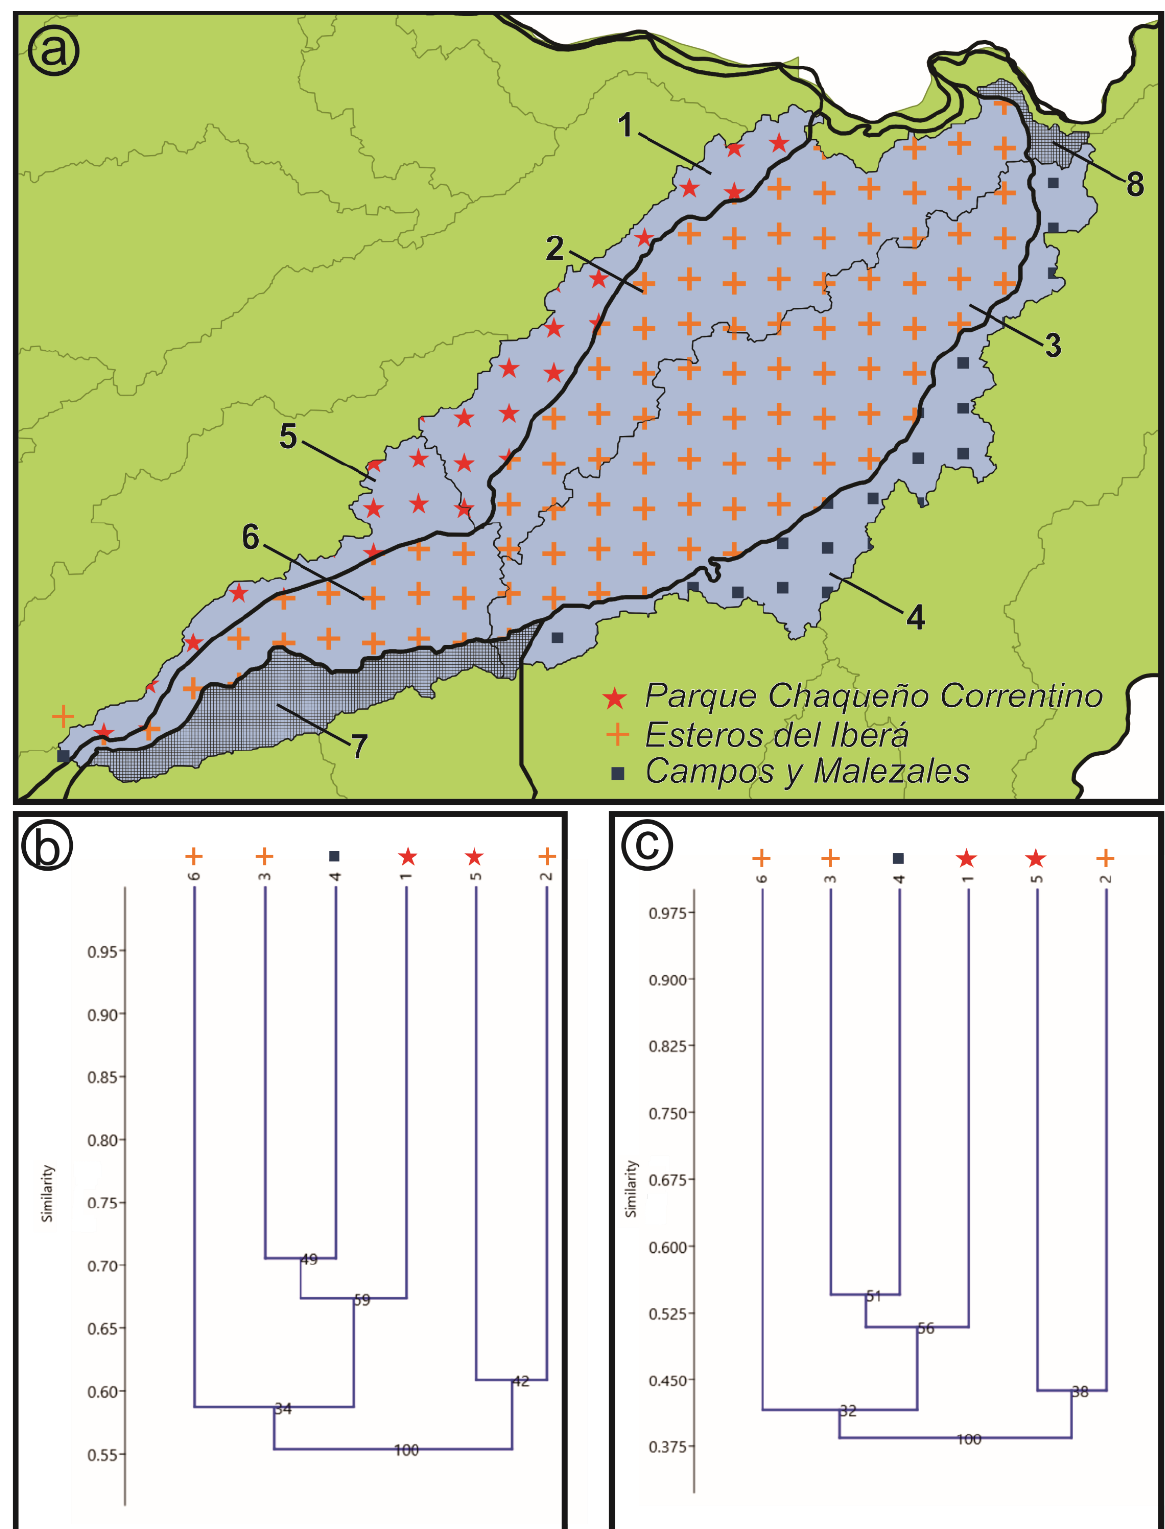
Figure 7. ( a ) Iber á Depression divided by the ecoregions, ( b ) Dendrogram showing similarity between areas (Sorensen–Dice), ( c ) Dendrogram showing similarity between areas (Jaccard). The dendrograms showed a CC > 0.96.